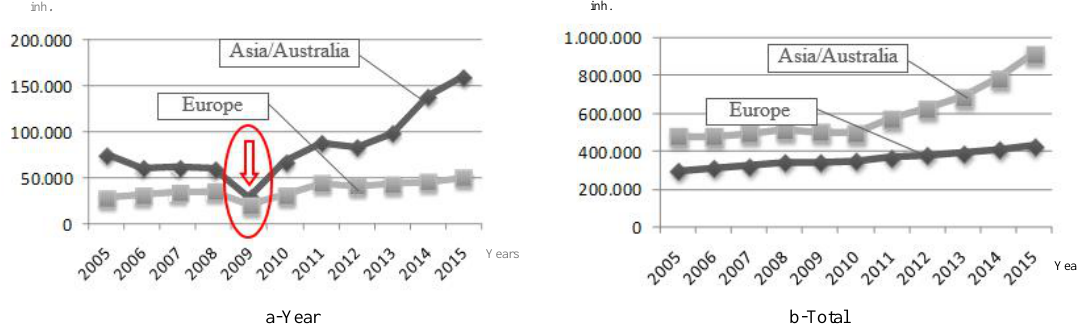
Fig. 2: Annual and total representation of industrial robots in automation of industrial production processes in Asia/Australia and Europe (Karabegović, 2016; Karabegović and Husak, 2014; 2016; Karabegović and Doleček,